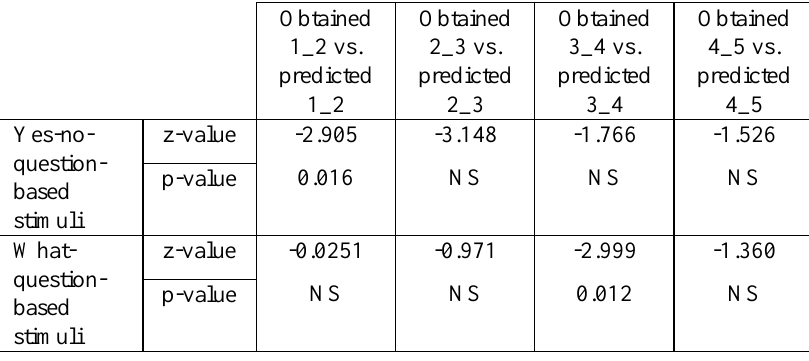
Table X. z- and p-values of four Wilcoxon matched pairs signed rank tests for each continuum comparing the obtained and predicted discrimination rate for each pair of